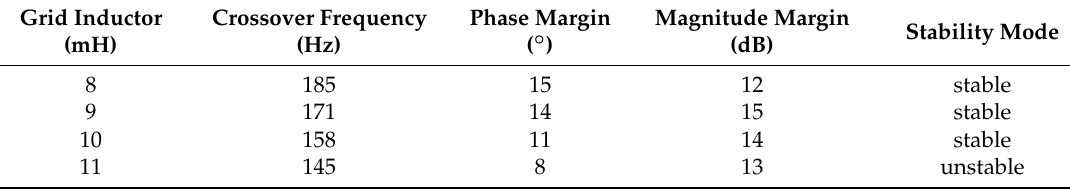
Table 5. Stability state when decreasing the PLL controller bandwidth by 30%.